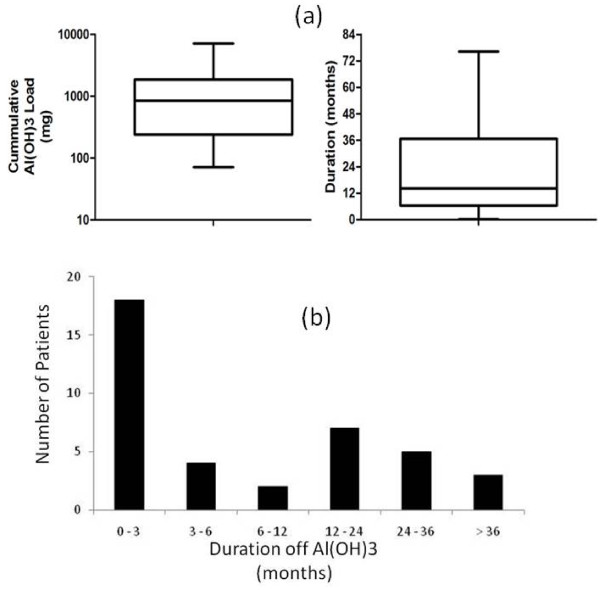
The amount of aluminium prescribed (load and duration) and the duration off the drug prior to DFO test.